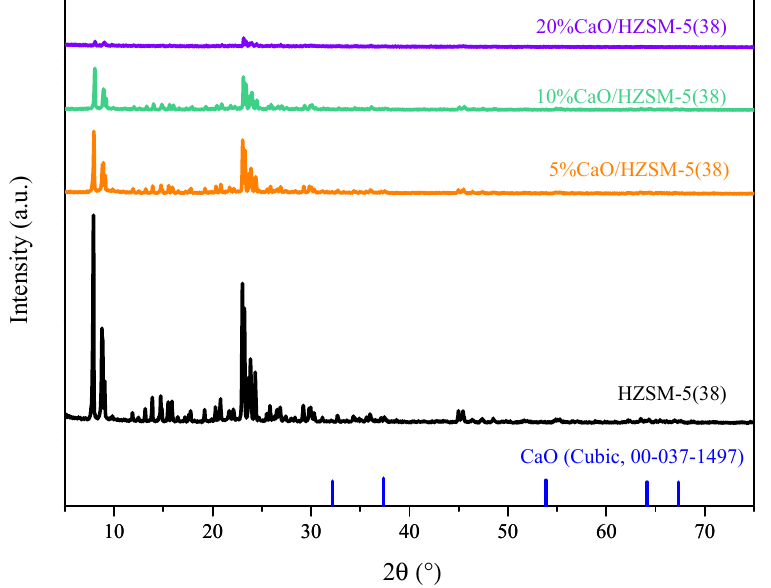
Figure 1. XRD patterns within the 2 θ range of 5° to 60° of 5%, 10% and 20% of CaO loading over HZSM-5(38) catalysts.